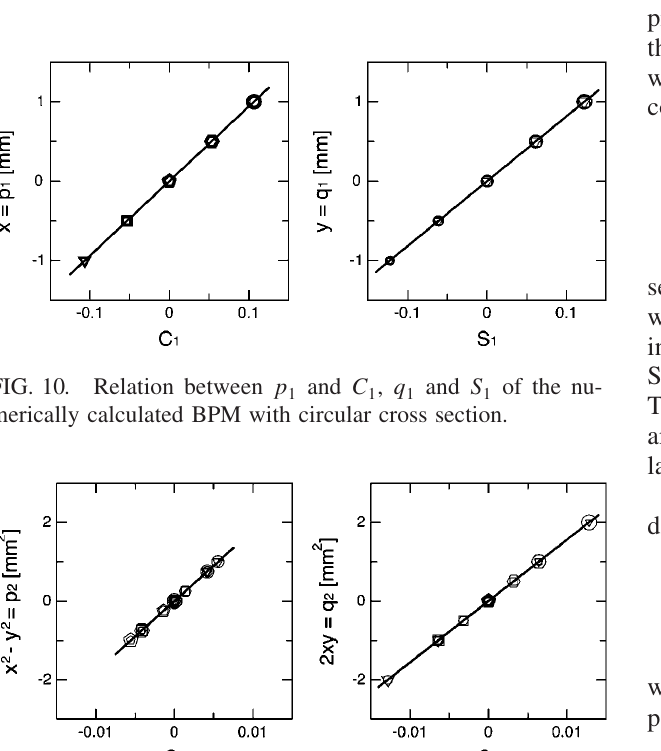
and C , q and S of the 2 2 2 2